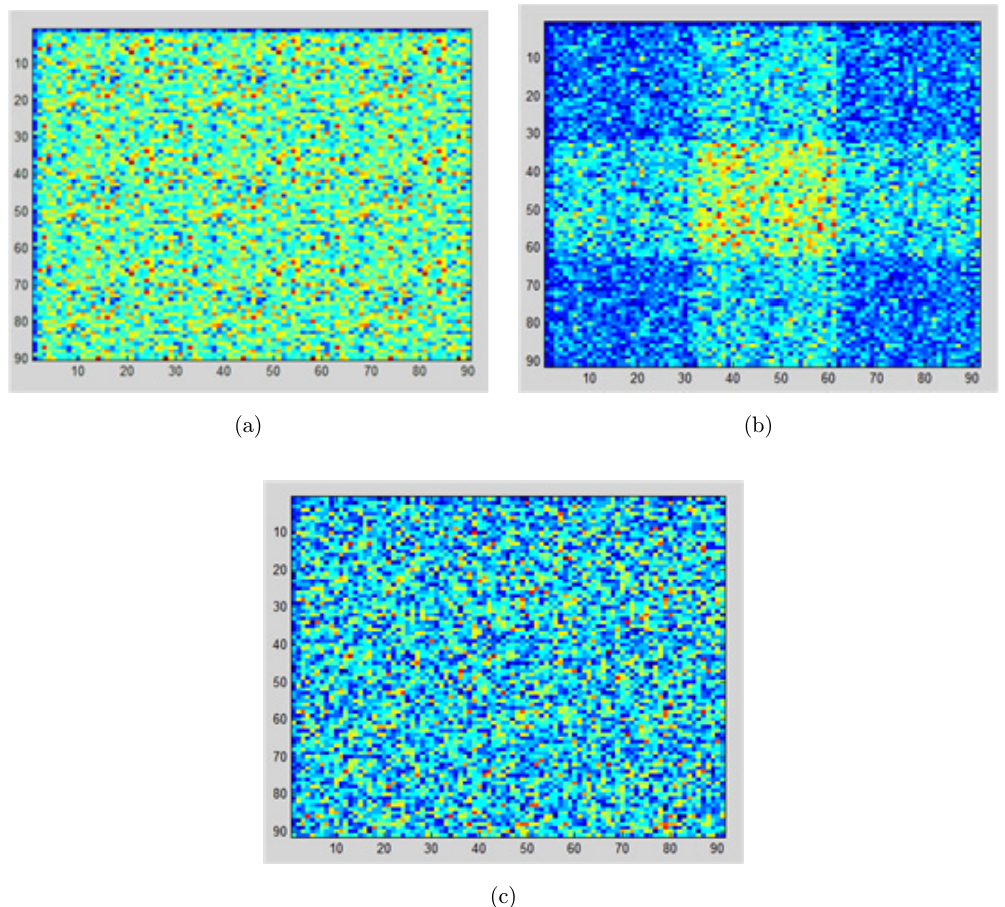
Fig. 5. Simulation results with stochastic number ranges of (a) [ (cid:2) 15, 15], (b) [ (cid:2) 45, 45] and (c) [ (cid:2) 75, 75],